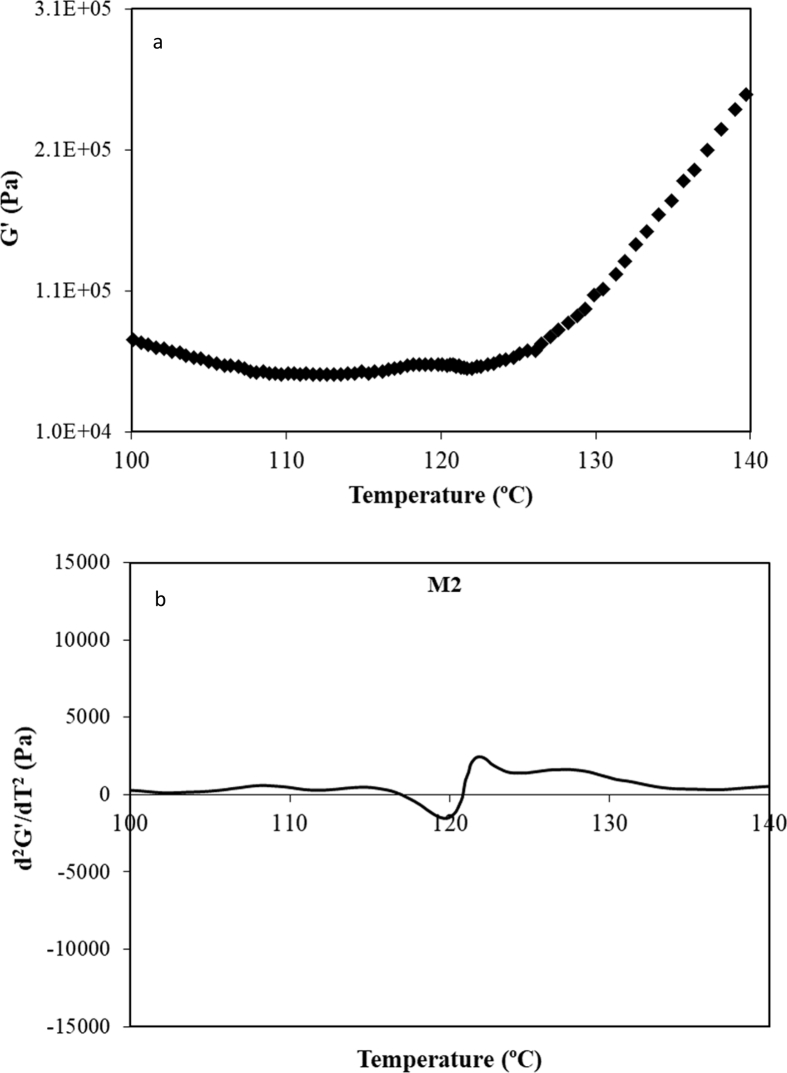
Experimental data of G′ vs temperature (a) and second derivative of G′(T) (d2G'/dT2) for DMTA experimental data of CD during M2 transition.